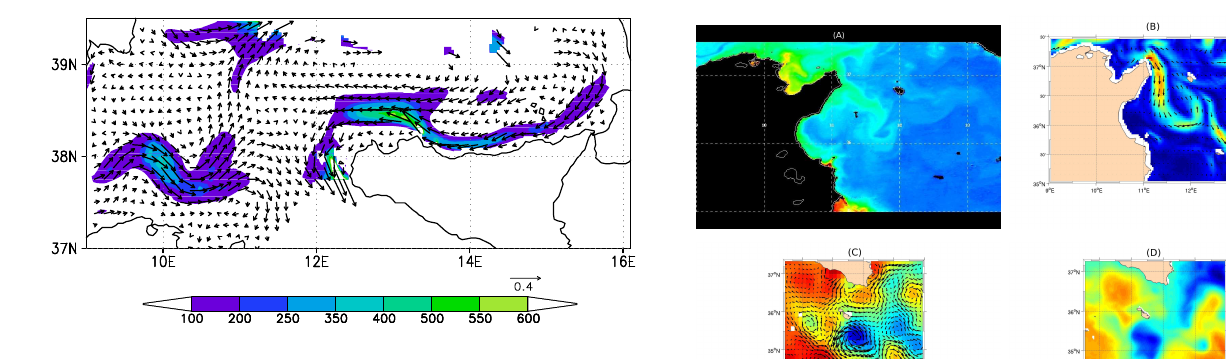
Fig. 8. Monthly mean map for the Sardinia-Tyrrhenian sub-region of MKE [cm 2 s − 2 ] in July averaged on the period 2008-2010 and vertically integrated from surface to 5m depth. It puts in evidence the presence of the WNSC flowing along the northern Sicilian coast. Fig. 10. Panel (A) : MODIS level-2 K490 image at 11 May 2009 where the Pantelleria Vortex is clearly defined south west of the Pantelleria island; panel (B) : simulated surface velocity field for the same day where the depression corresponding to the vortex is clearly shown in the same position of the observation; panel (C) : 45 Sea Level Anomaly [m] map at 30 January 2009 where the Med- ina Gyre is evident as a wide depression (cyclonic) south of Malta; panel (D) : the Medina Gyre at 1 February 2009 well identified in the simulated surface elevation